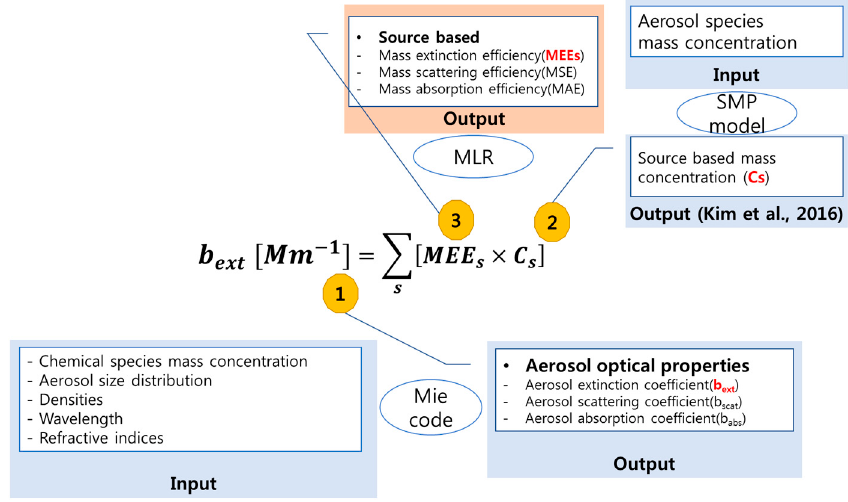
Figure 1. Schematic diagram showing the steps to calculate the source-based aerosol optical properties of polydisperse aerosols using the Solver for Mixture Problem (SMP) model and Mie theory.